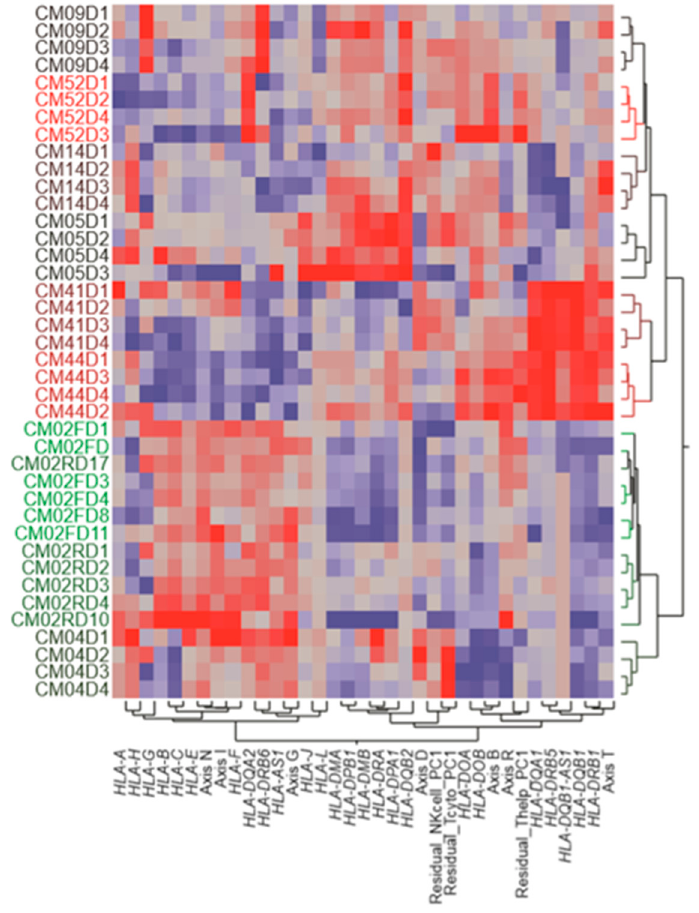
Figure 5. Two-way hierarchical clustering of HLA complex gene expression by individual and time. Each row represents one patient on the day indicated by the last number of the label, and each column is the standardized expression of the indicated HLA gene or lymphocyte activity estimate. The figure highlights three clusters of co-expression, namely, HLA class I to the left and two HLA class II clusters in the middle and right of the grid.